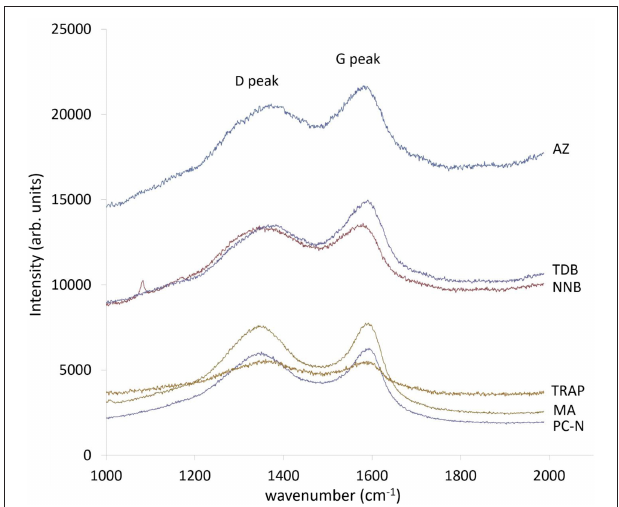
FIGURE 3 | Raman spectra of all samples analyzed in this study. For convenience, spectra with broad similarities are grouped on the figure, although all material analyzed displayed some form of both G and D peaks; this, and the similarities and contrasts between material, is fully discussed in the text.